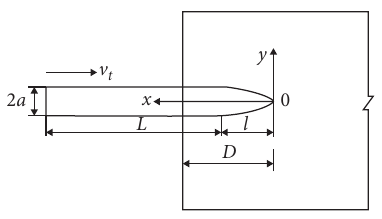
Figure 2: Dimensions of penetration